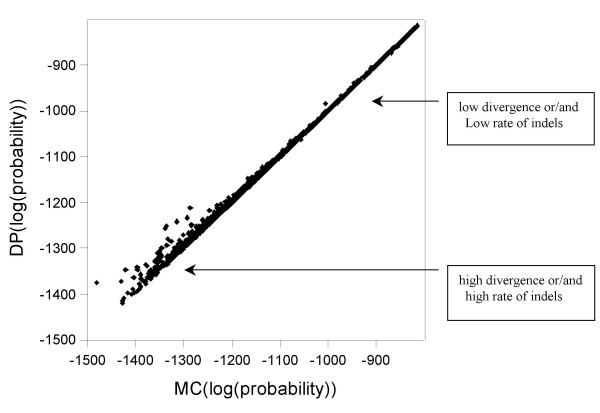
Probability test using the probability function of MCALIGN2(DP), comparing the performances of alignments produced by the DP method and the MC method. All the values here are log values.